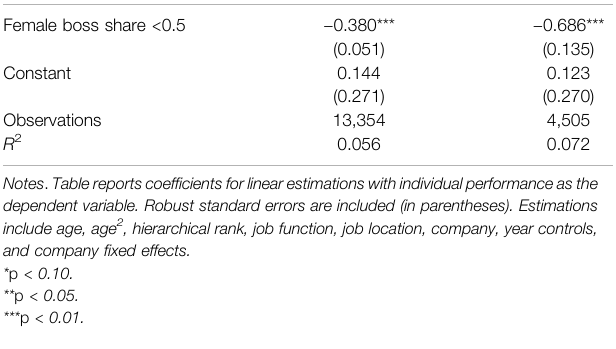
TABLE 6 | Regression results for linear downward- fl owing effects for men and women with female boss share < 0.5. Individual performance